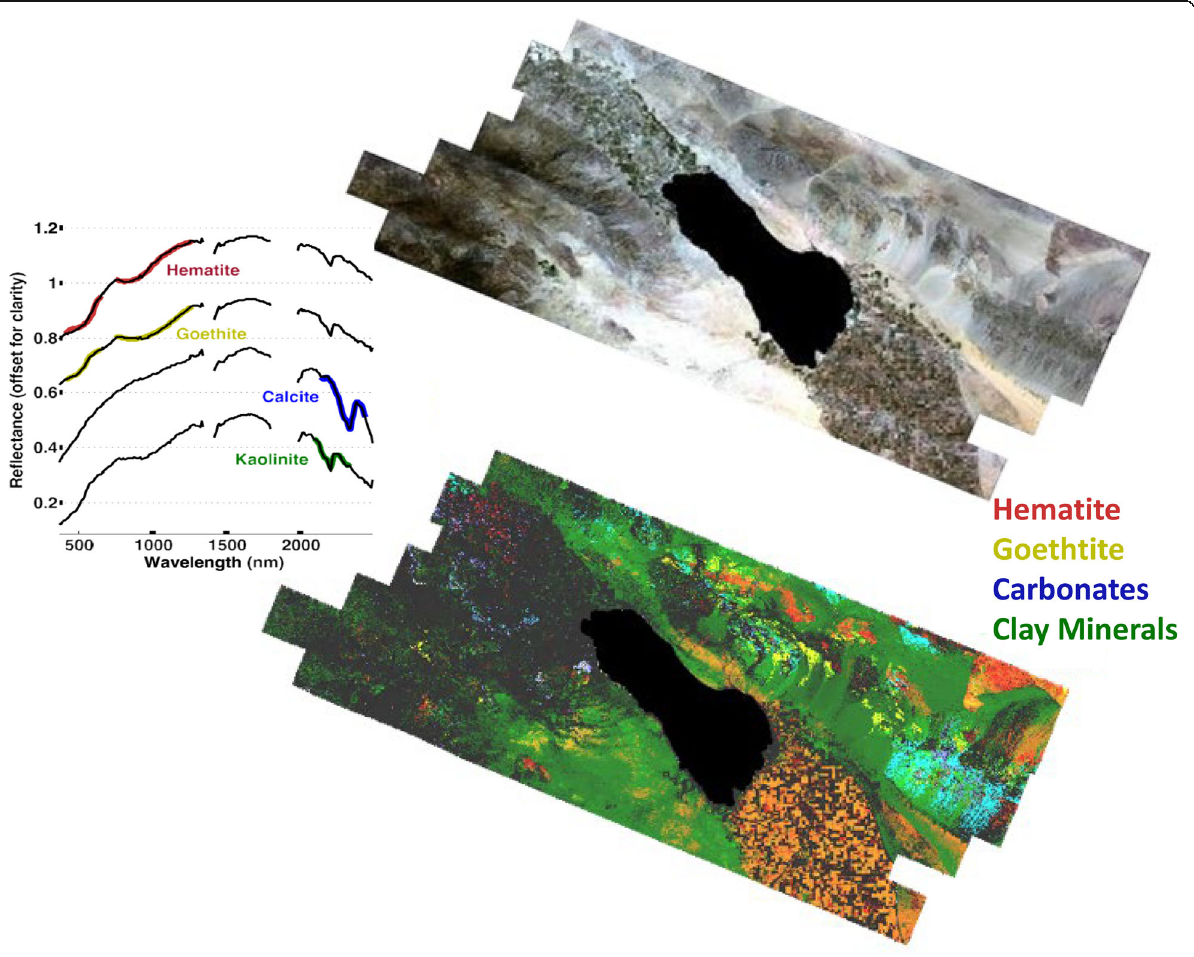
Fig. 24 Illustration of mapping mineral exposures in arid and semiarid sites that are sources for airborne dust that gets into the upper troposphere and stratosphere, absorbing or reflecting soil radiation, thus affecting the radiation budget of the earth. While the true color image makes the area look to be composed of similar geologic minerals (being different tones of gray), but when locations of surface minerals are color coded and mapped, the complex surface minerology is evident. In this example, the hematite and goethtite minerals are dark and absorb more solar energy while the carbonates and clay minerals are light-colored and absorb less energy, and scatter energy back toward space. Data was acquired for this example on 03/31/2014 by the Airborne Visible Infrared Imaging Spectrometer (AVIRIS) over the Salton Sea, California, flown on the NASA ER-2 aircraft at 30 km altitude